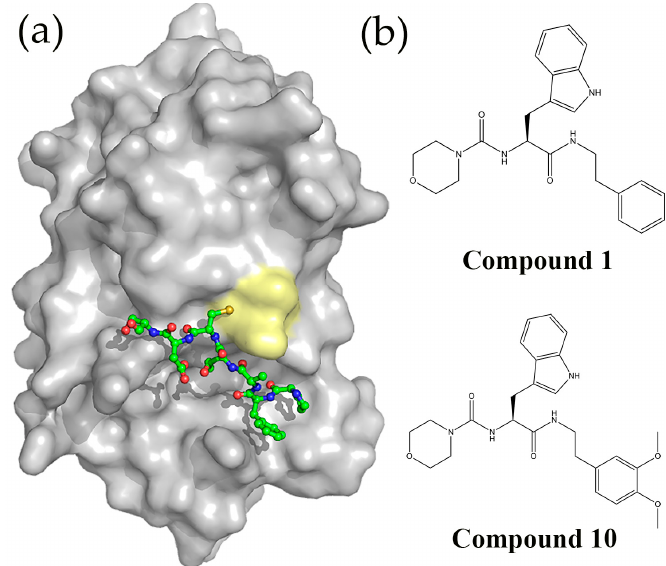
Figure 5. ( a ) Crystal structure of EcDsbA (depicted in surface representation) in complex with the EcDsbB derived peptide PFATCDS (shown in ball-and-stick representation) (PDB 4TKY). The EcDsbA active site is colored yellow; ( b ) Chemical structures of a two peptidomimetic compounds that inhibit DsbA. The left panel shows the top hit obtained from the virtual screening of library of peptidomitetics (compound 1 , (S)- N- (3-(1 H- indol-3-yl)-1-oxo-1-(phenethylamino)propan-2-yl)morpholine-4-carboxamide). The right panel shows a synthesized peptidomimetic that inhibited EcDsbA activity at millimolar concentration (compound 10 , ( S )- N- (1-((3,4-dimethoxyphenethyl)amino)-3-(1 H- indol-3-yl)-1-oxopropan- 2-yl)morpholine-4-carboxamide).